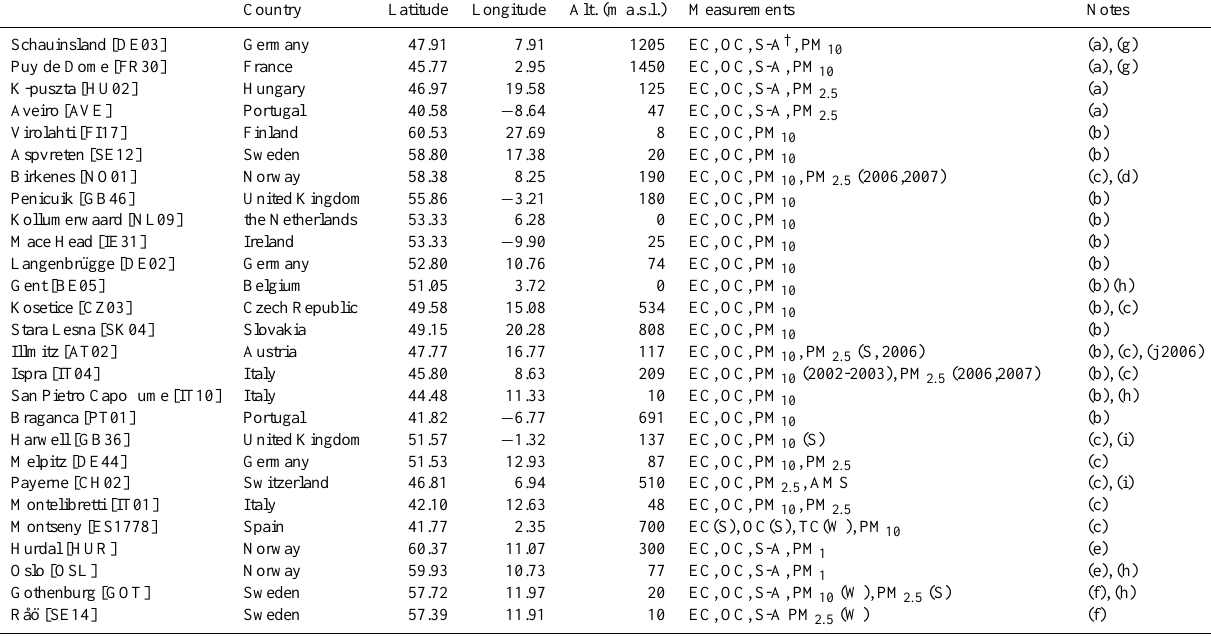
Table 2. Measurement sites and campaigns used in this study (see also Fig. S1).